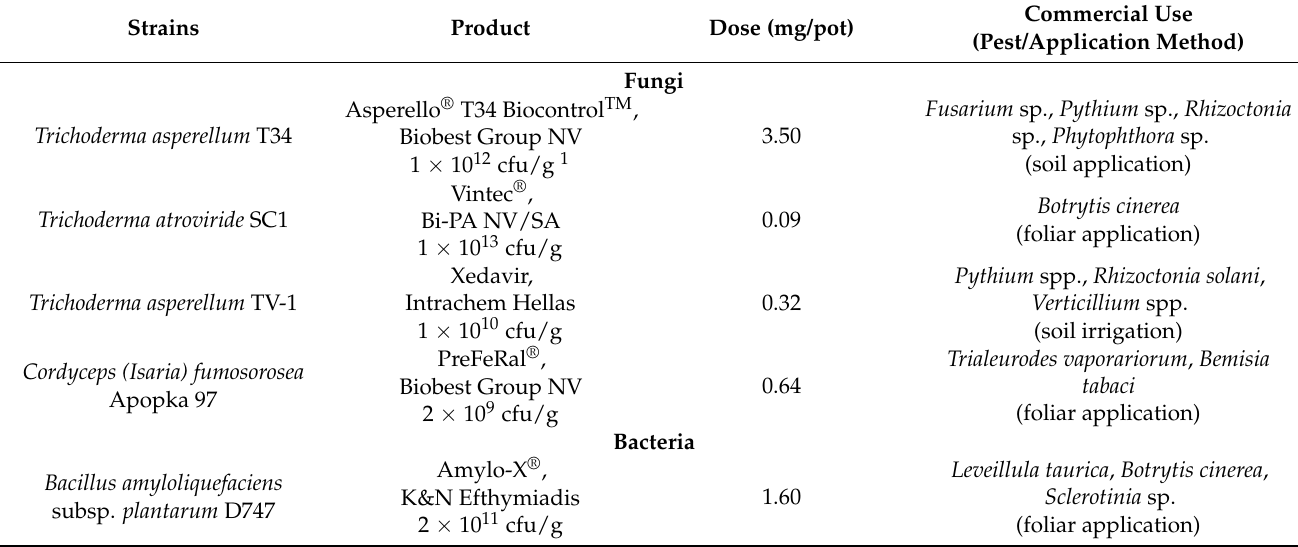
Table 1. Strains of beneficial microbes that were tested for their plant-mediated effects against spider mites and aphids in